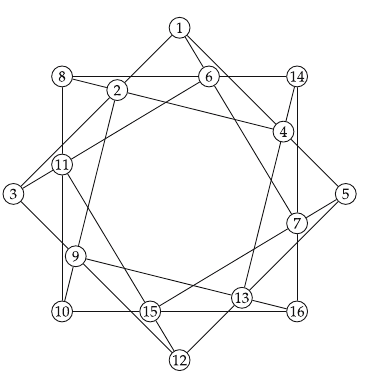
Figure 11: The unique cyclic 16 316 - con fi guration inducing a triangular matroid.